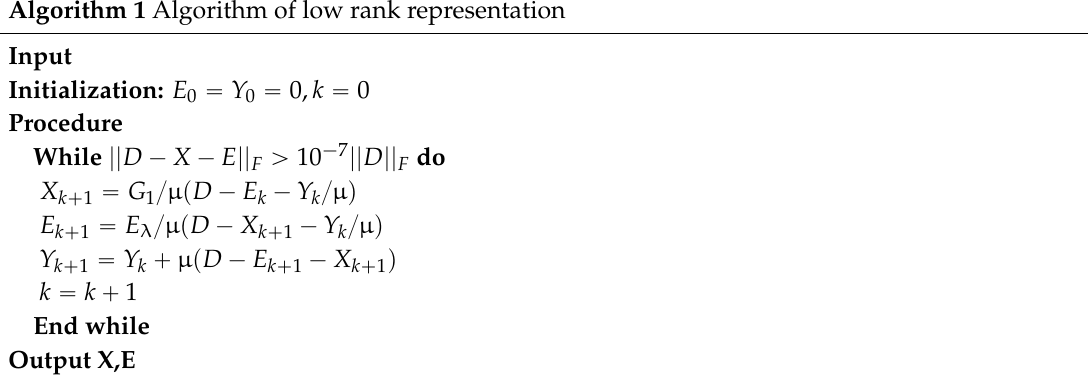
Algorithm 1 Algorithm of low rank